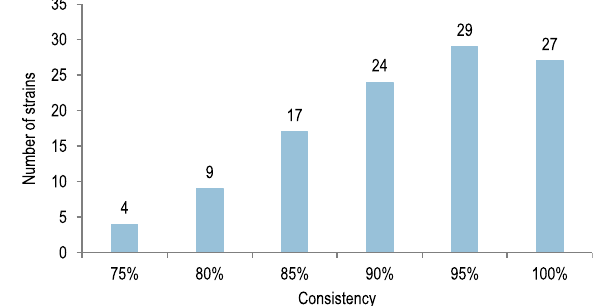
Fig. 2 Quali fi cation of the 110-strain panel in enc-hSBA: distribu- tion of the MenB strains by consistency (percentage of samples with the same result obtained in triplicate testing). Enc-hSBA, serum bactericidal activity assay using endogenous human comple- ment; MenB, serogroup B meningococcus.